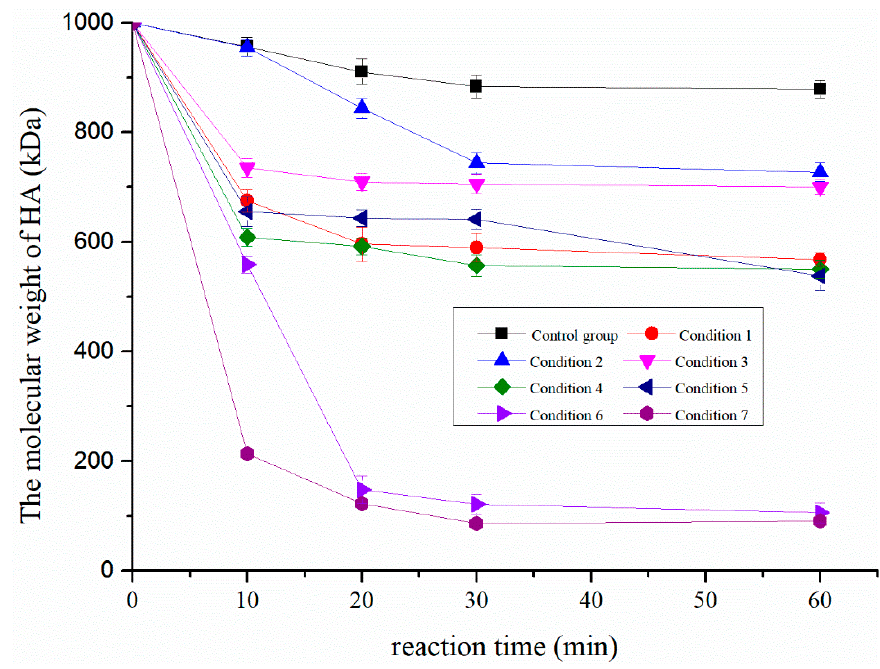
Figure 1. Comparison of degradation efficiency of hyaluronic acid under different conditions.